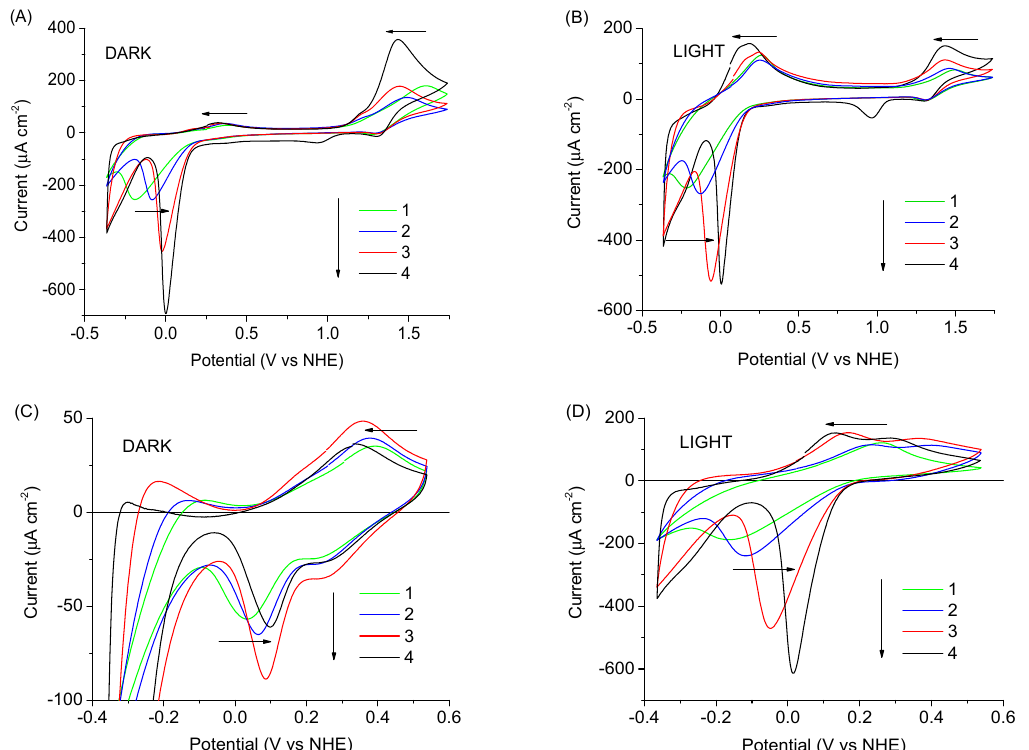
Figure 5. Cyclic voltammograms of TiO 2 photoanode sensitized with RuP and RuOEC in EPA electrolyte containing KCl of different concentration: pure (1), 0.001 M KCl (2), 0.01 M KCl (3), and 0.1 M KCl (4). Scans in graphs ( A , C ) were recorded in dark condition, scans in ( B , D ) were recorded under 1 sun illumination with a UV cut-off filter ( λ ≥ 400 nm).